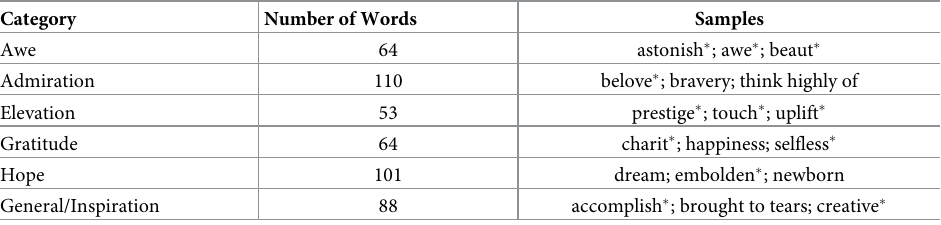
Table 1. Summary of the initial version of the self-transcendent emotion dictionary.